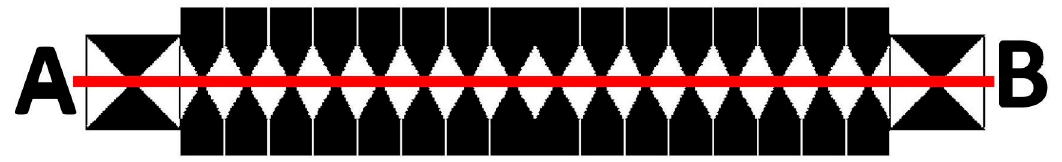
Figure 5. Calibration pattern for spectral calibration of HSLS V9.